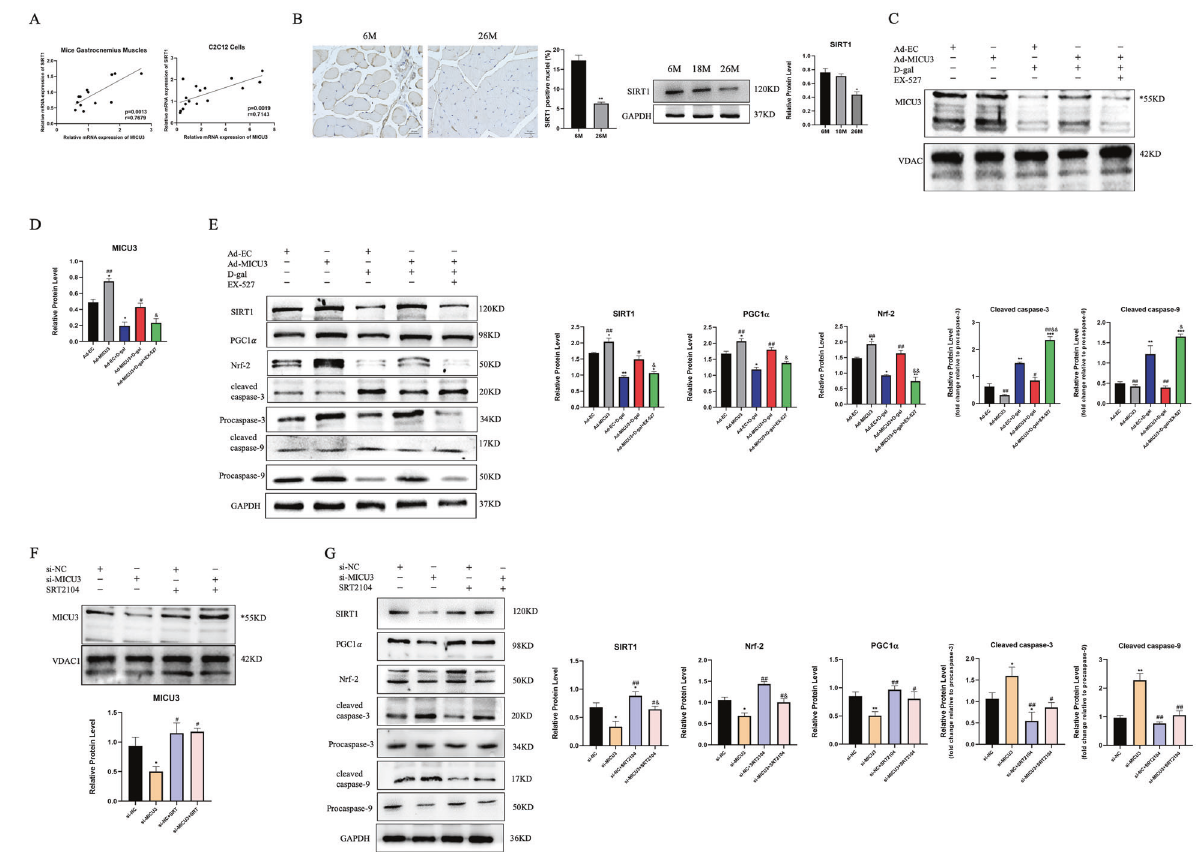
Fig. 7 SIRT1 plays a critical role in the effect of MICU3. A Correlation graphs between the mRNA expression of MICU3 and SIRT1. B IHC and western blot for SIRT1 in mice from different age groups (magni fi cation ×400; scale bar = 20 μ m, * p < 0.05 vs. the 6M group; n = 3). C , D Western blot and quanti fi cation of MICU3. VDAC was used as the loading control. *indicates target bands. E Western blot and quanti fi cation of SIRT1, PGC1 α , Nrf-2, cleaved caspase-3, cleaved caspase-9, Procaspase-3, and Procaspase-9. GAPDH was used as the loading control. (* p < 0.05 vs. the Ad-EC group; # p < 0.05 vs. the Ad-EC + D -gal group; & p < 0.05 vs. the Ad-MICU3 + D -gal group; n = 3). F Western blot and quanti fi cation of MICU3. VDAC was used as the loading control. *indicates target bands. G Western blot and quanti fi cation of SIRT1, were analyzed using a one-way